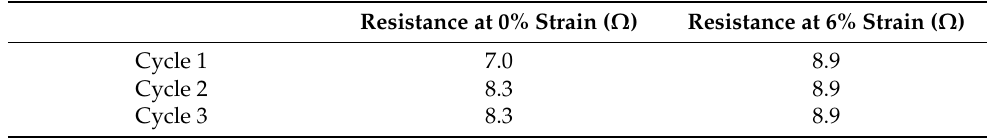
Table 5. Resistance of PVA printed silver over three wet strain